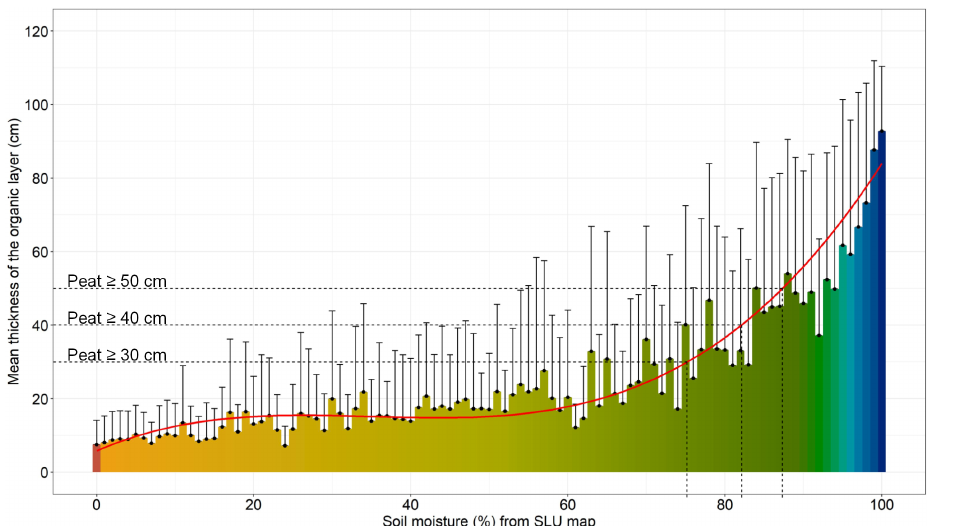
Figure 3. The red line depicts the cubic relationship ( R 2 = 0.66) between the thickness of the organic layer in SFSI plots and the probability for the soil being wet according to the SLU soil moisture map (Ågren et al., 2021). The colored bars and black dots indicate the mean organic layer thickness (in the calibration dataset) for soil moisture variation from 0 (dark orange) to 100 (dark blue) as extracted from the SLU soil moisture map (shown using the same color code). The error bars represent the standard error of mean of the organic layer thickness at each soil moisture level. Note that the soil moisture in percentages denotes the probability of a soil being wet expressed as percent, not the volumetric soil water content. Table 1. Evaluation metrics of different maps of peat soils. TP = True positives, TN = True negative, FP = False positives, FN = False negatives. The other metrics are explained in Eqs. (1)–(6). Kappa refers to Cohen’s kappa and MCC to the Matthews correlation coefficient. The peat maps that we predicted in this study are highlighted in italics. The topographic and Quaternary deposits maps are existing national products. TP TN FP FN Accuracy Precision Recall Specificity Kappa MCC